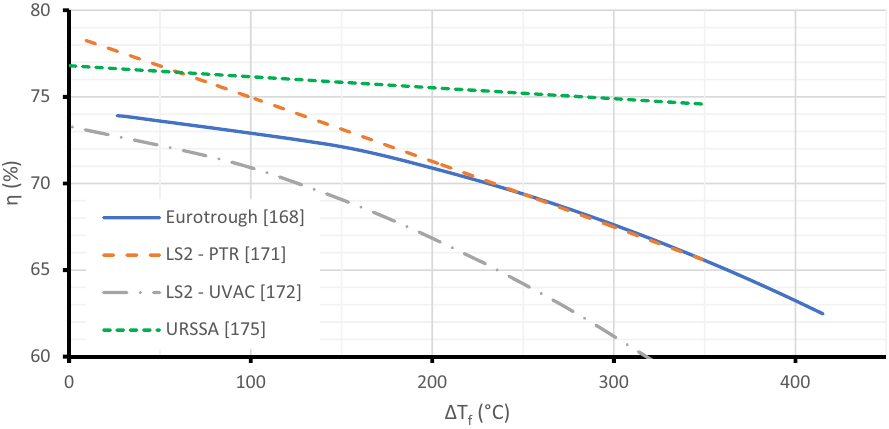
Figure 29: Thermal e ffi ciency curves of large -